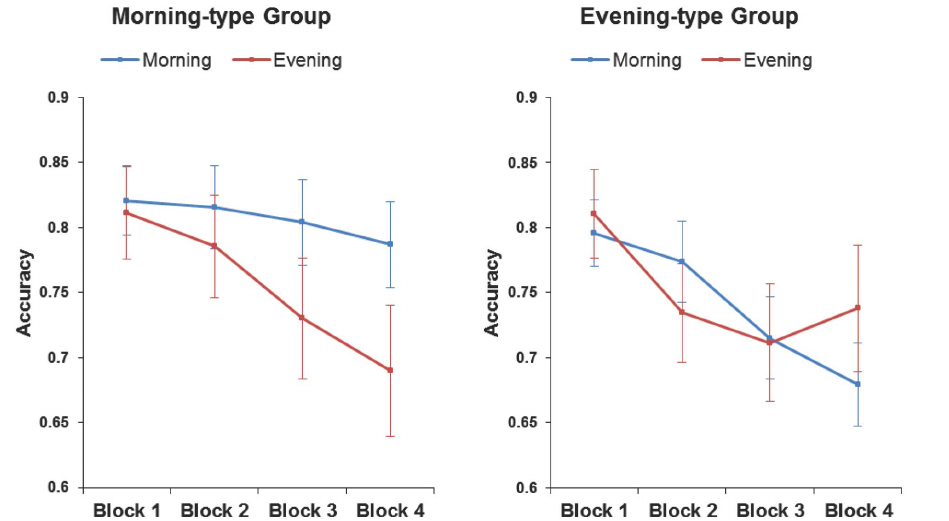
Figure 3. Accurate responses as a function of chronotype, testing time and block for the precision strategy condition. Each chronotype showed marked performance decrements at the non-optimal testing time. Vertical bars denote + / 2 standard error of the mean.